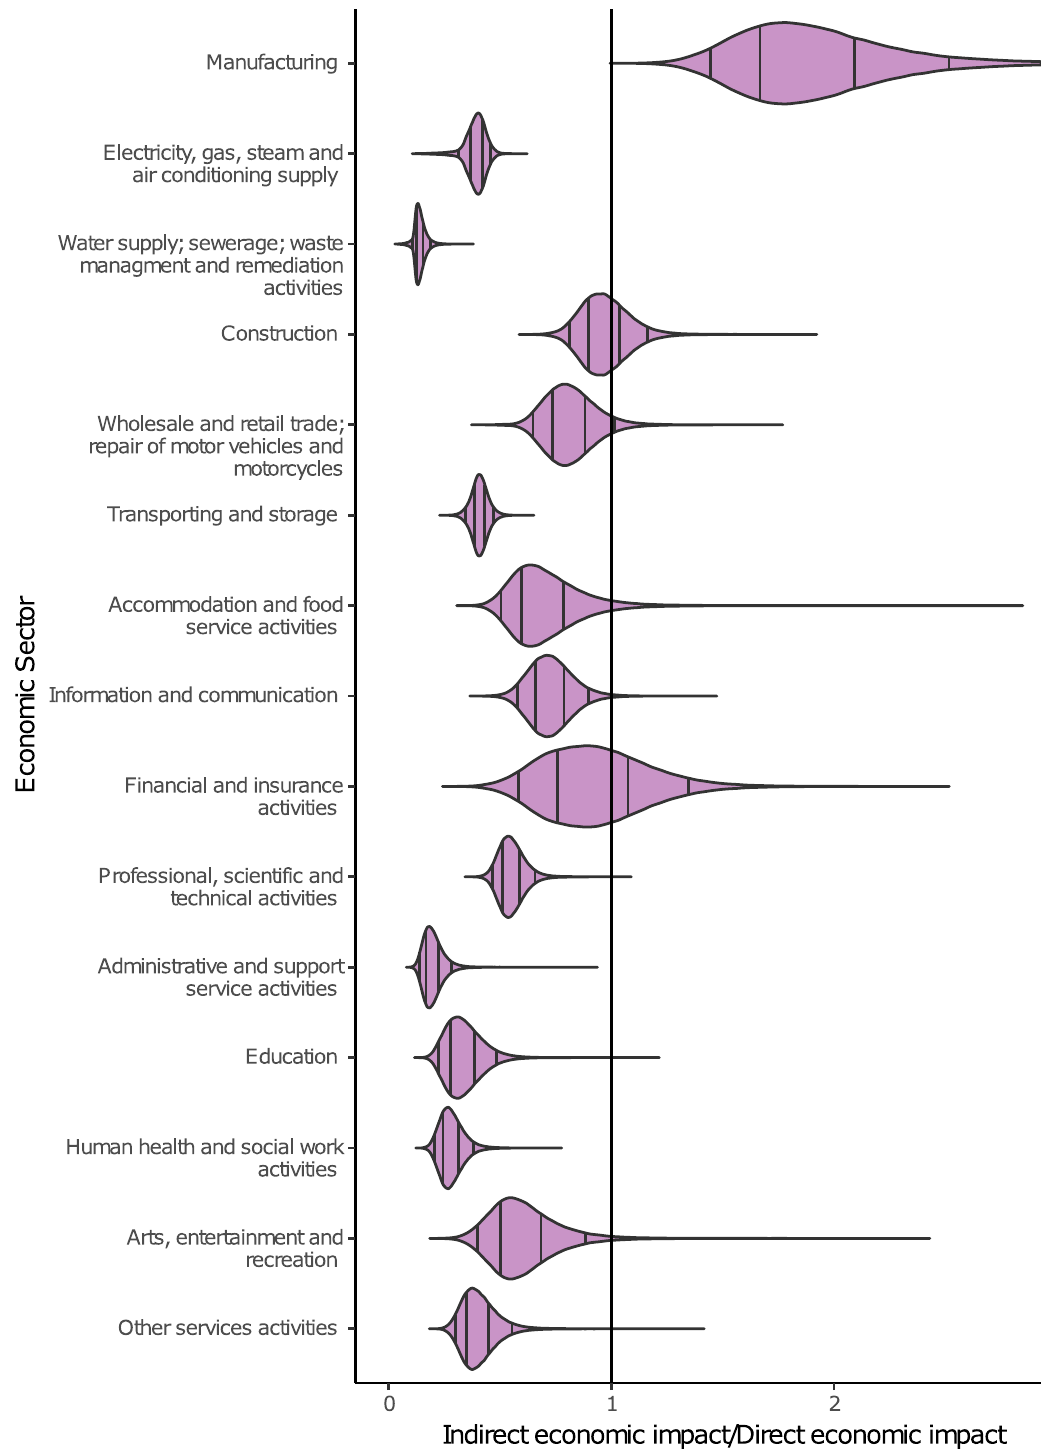
Fig 5. Distributions of the ratio between indirect and direct estimated economic impacts per economic sector. The black lines indicate the 50% and 90% intervals.